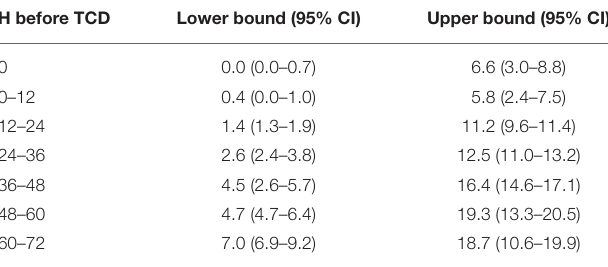
TABLE 4 | Estimated lower and upper bounds for the distribution of Catalyst Progesterone concentrations (nmol/L) in whelping dogs at different time ranges before first detected cervical dilatation using bootstrapped